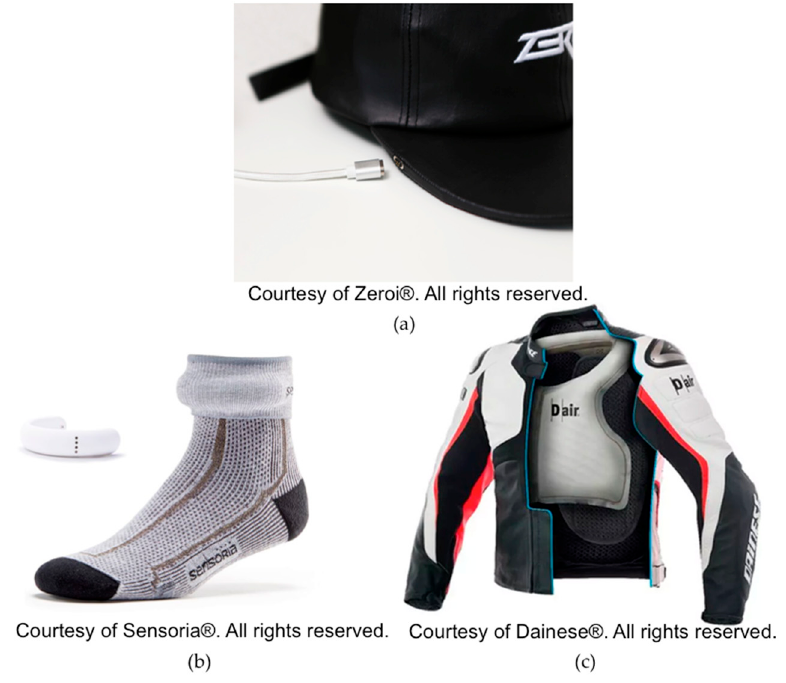
Figure 4. Wearable e-textile transducers. ( a ) Zeroi—Bone conduction hat [61]; ( b ) Sensoria—Intelligent sock with heart rate measurement system [62]; ( c ) D-air—Airbag jacket (motorcycling protection) [63].